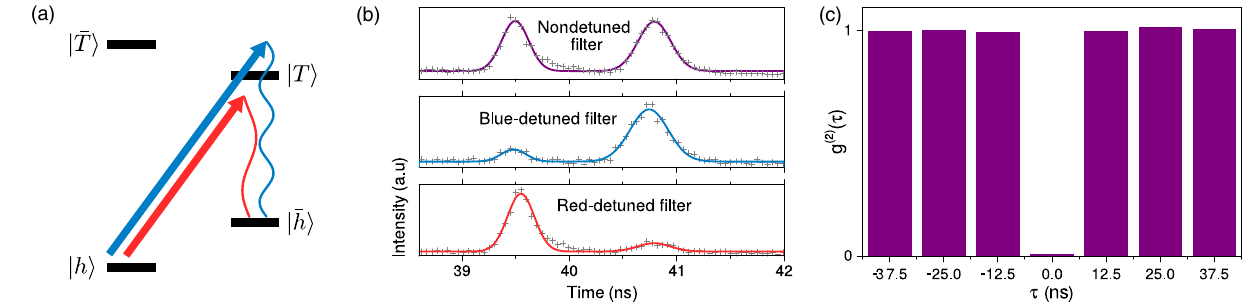
FIG. 3. (a) An illustration of driving the Raman transition with a red- and a blue-detuned laser. (b) A time-resolved plot and fit of the output light when a red-detuned laser is used to drive the Raman transition in time bin 1 and a blue-detuned laser is used to drive the transition in time bin 2, shown for the following situations: The spectral filter is not detuned (top panel); the spectral filter is blue detuned (middle panel); the spectral filter is red detuned (bottom panel). (c) The result of a second-order correlation function measurement on the Raman scattered light generated using two detuned lasers, both of which are pulsed in time bins 1 and